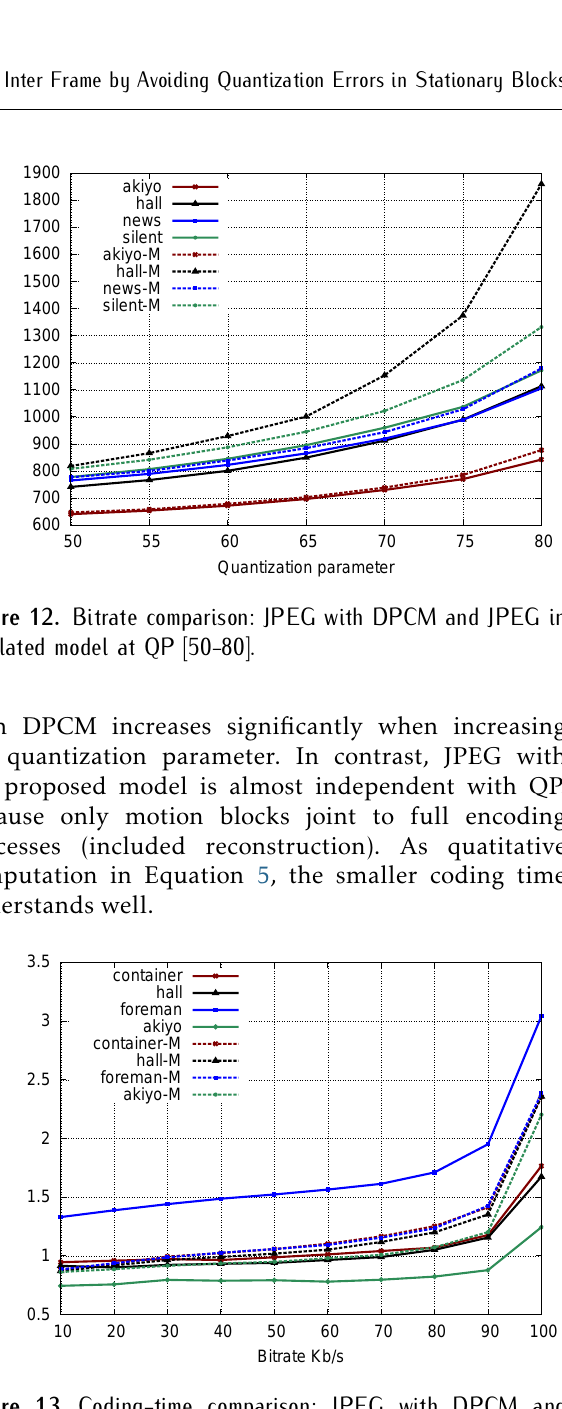
Figure 13. Coding-time comparison: JPEG with DPCM and JPEG in the proposed